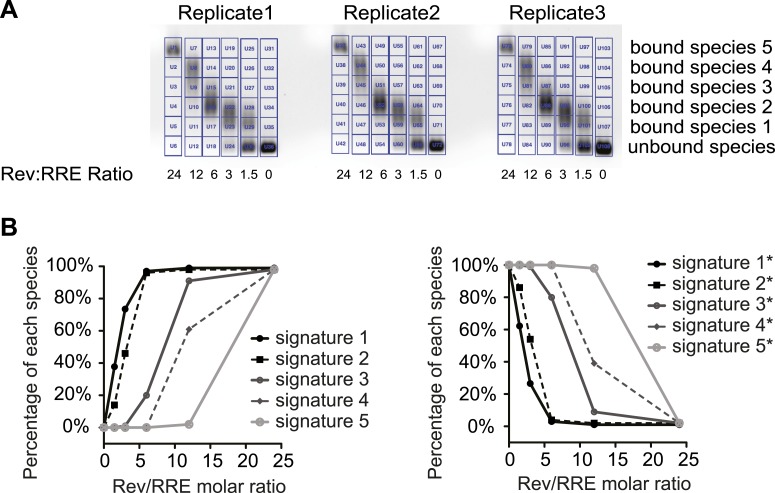
SHAPE signatures generated by EMSA.(A) EMSAs for quantification of different Rev-RRE intermediate states. (B) SHAPE signatures calculated based on EMSAs results. Left, SHAPE signatures representing nucleotides with increased SHAPE reactivity upon Rev binding. Right, SHAPE signatures representing nucleotides with decreased SHAPE reactivity upon Rev binding.